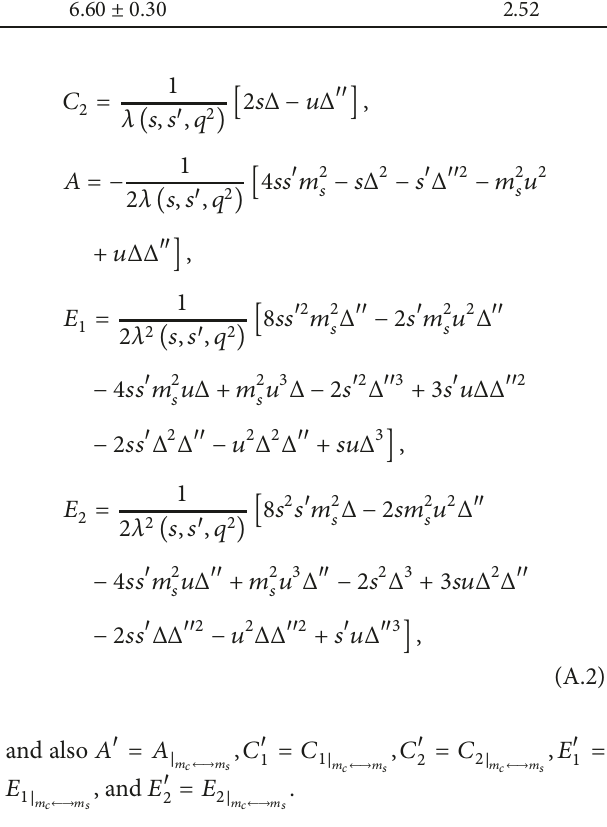
Table 5: Values of the strong coupling constant reporting different reference of the coupling constant 𝑔 퐷 ∗ 퐷 ∗ 휌 [2, 3, 21, 22]. 𝑔 Ours Reference [2,